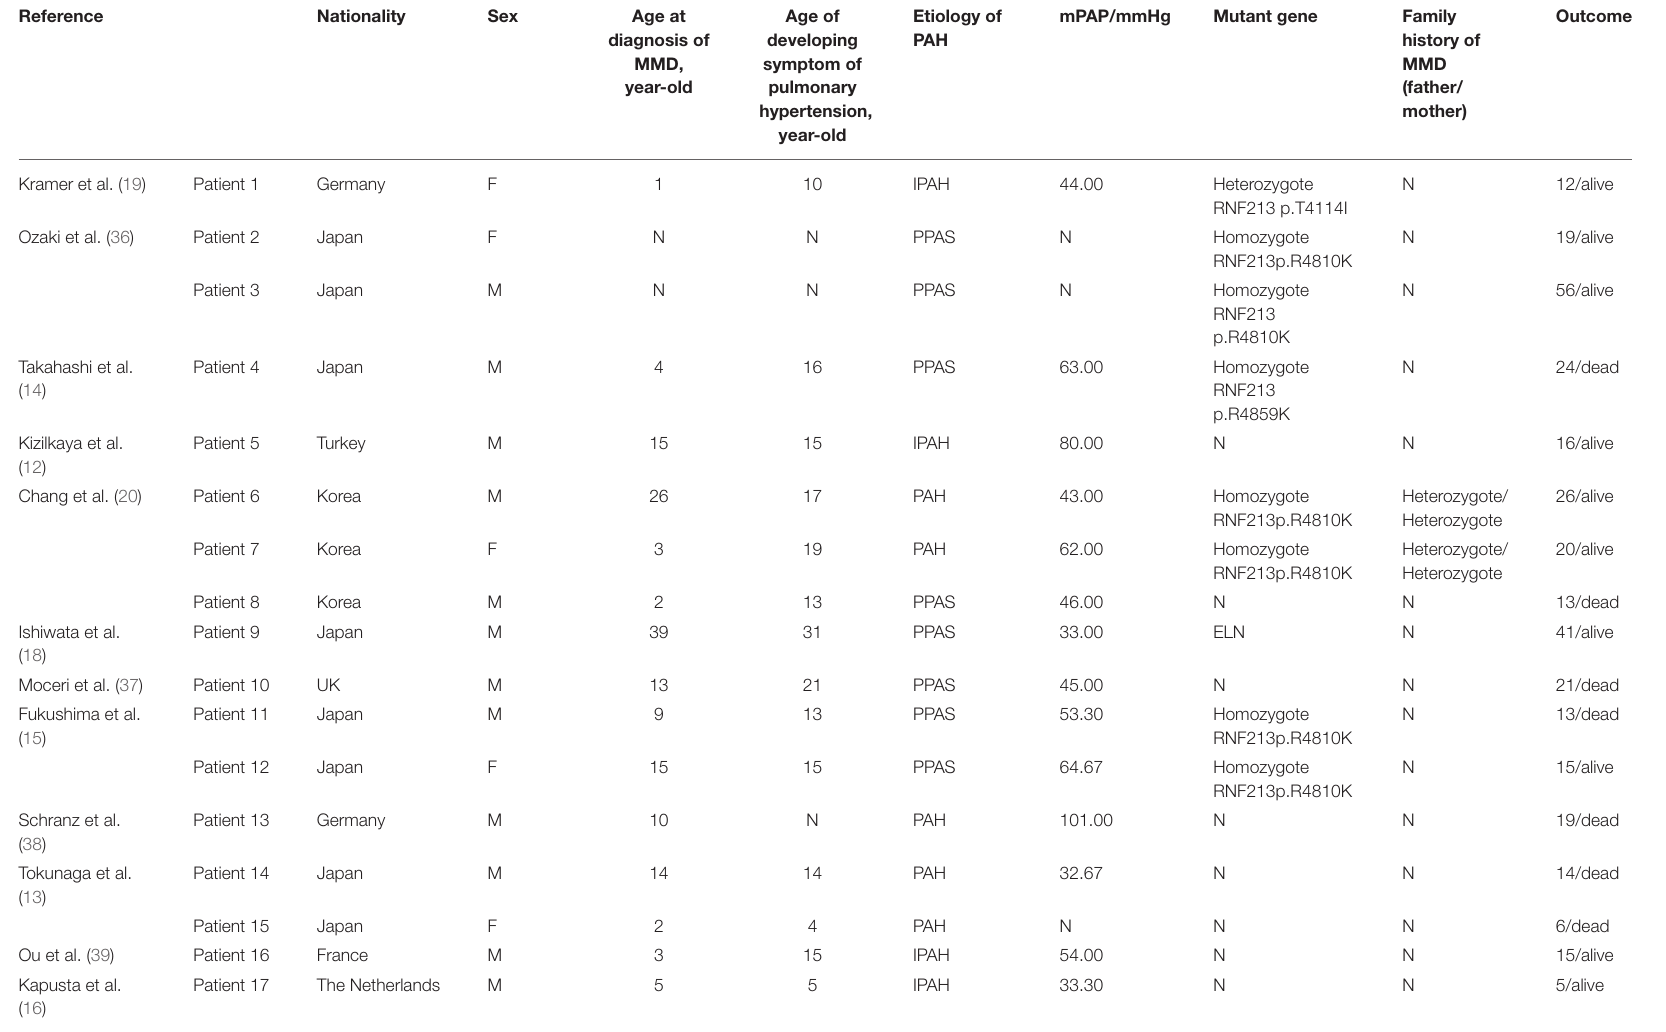
TABLE 1 | Case reports about patients with pulmonary hypertension and Moyamoya